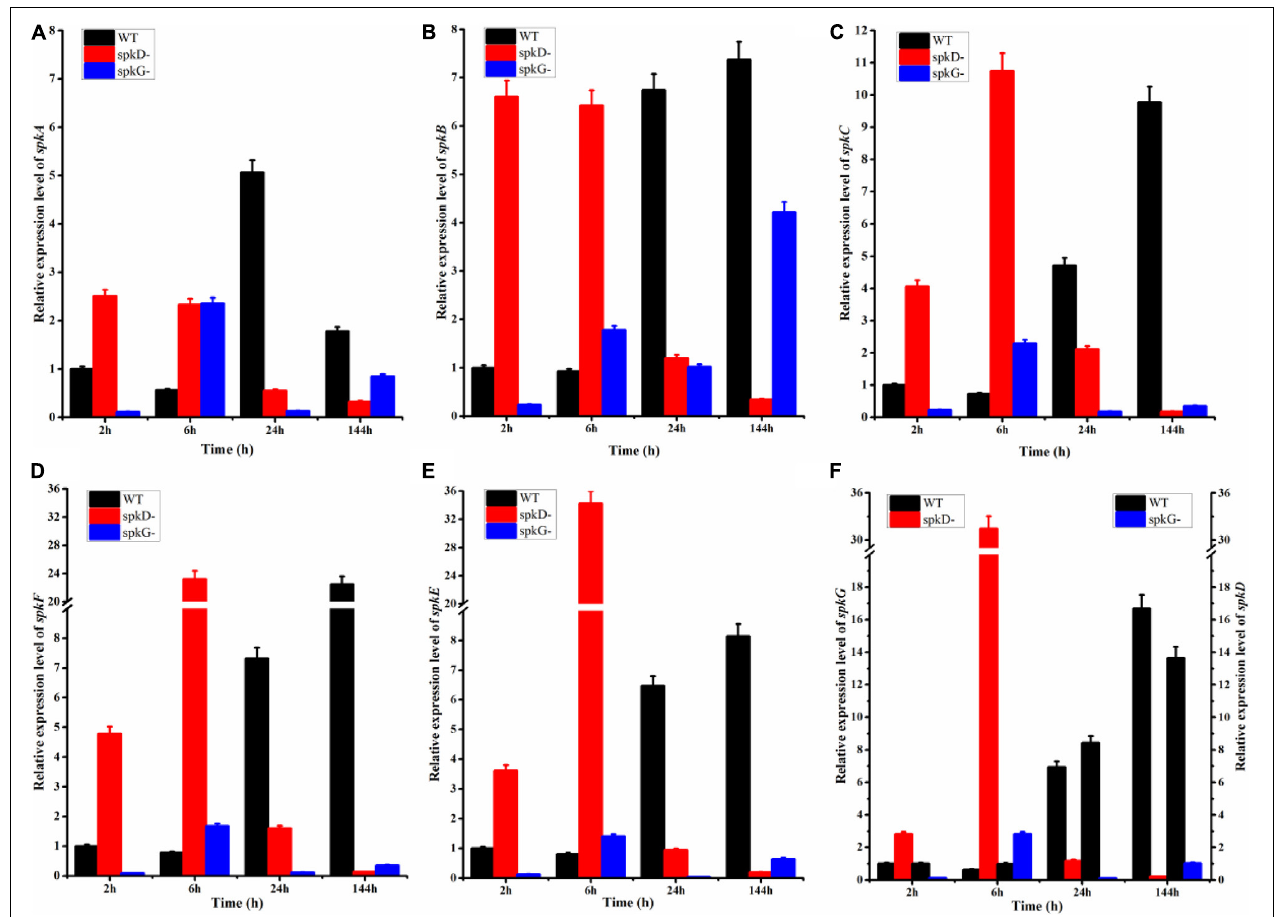
FIGURE 3 | Changes in serine/threonine kinase (STK) gene expression in wild type and mutant strains detected after different periods of exposure to normal light. WT represents wild type Synechocystis sp. PCC6803; spkD - represents the spkD knockout mutant; spkG - represents the spkG knockout mutant. The experiment was carried out under a normal light intensity of 40 µ mol · m − 2 · s − 1 . (A–E) show the relative expression levels of spkA , spkB , spkC , spkF, and spkE , respectively, in the wild type and two mutant strains. (F) Relative expression levels of spkG in the wild type and spkD -. The data correspond to the left vertical axis. The black bars represent the wild type. Synechocystis sp. PCC6803, and the red bars represent the mutation that knocked out spkD . The right vertical axis shows the relative expression levels of spkD in the wild type and spkG -, and the black bar represents the wild type. The blue bar represents the mutation that knocked out spkG . Values are means ± SD (bars) of three independent experiments conducted on different days. The absence of a bar indicates that the SD falls within the symbol.